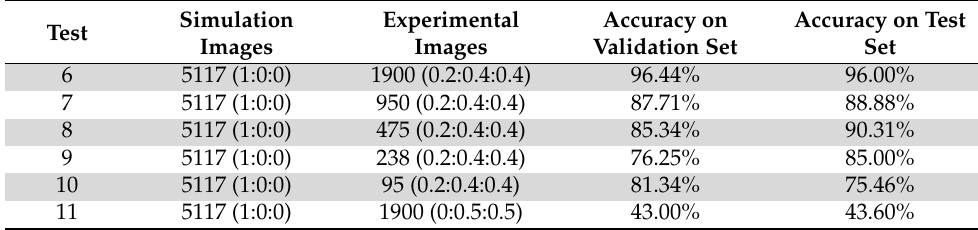
Table 2. Training results with hybrid